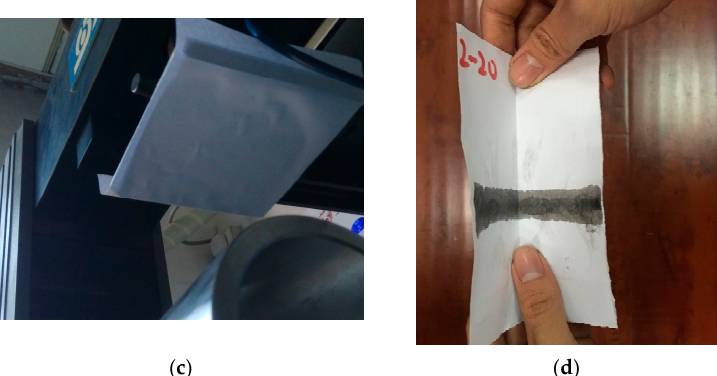
Figure 9. The process of the ink print test: ( a ) Paste a printing paper on the plane fixture. ( b ) Distribute some ink evenly on the hose. ( c ) Put the hose between the two fixtures and press it. ( d ) Tear off the printing paper and fold it up to create a line in the middle of the print.